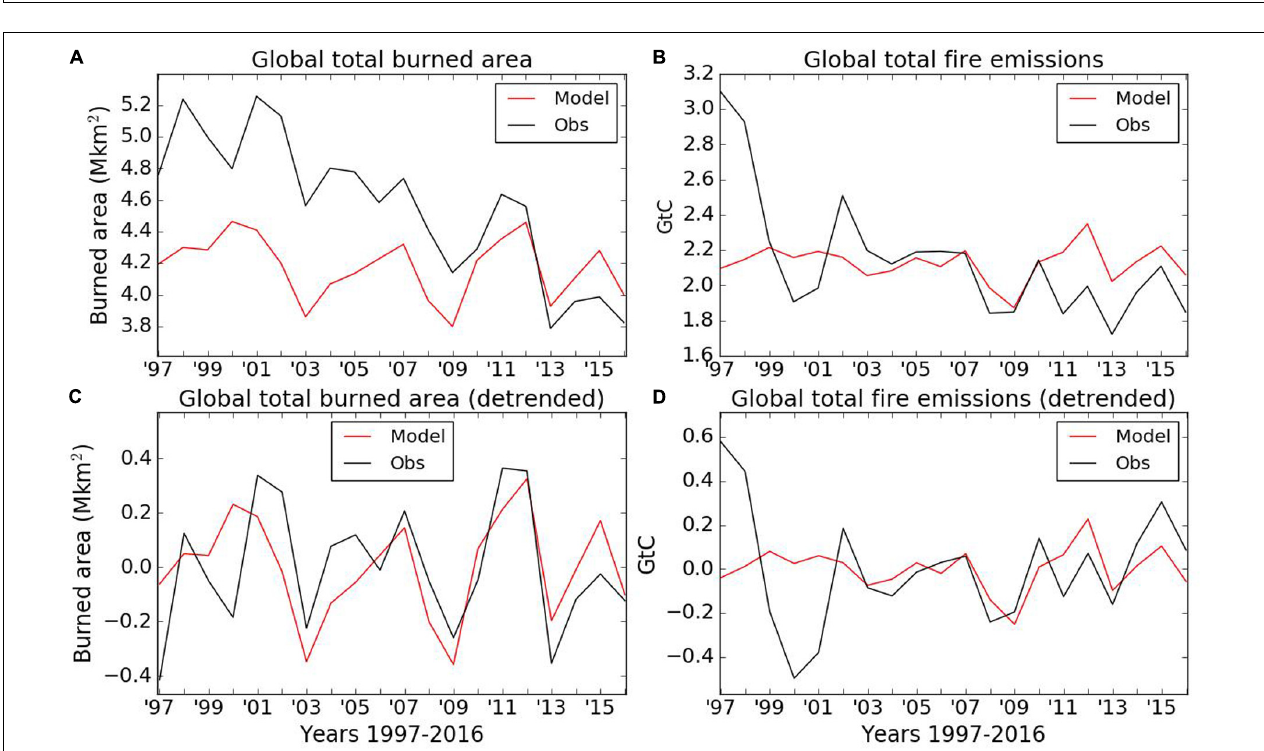
FIGURE 1 | Gridbox total burned area from GFED observations (A) and as modeled by JULES-INFERNO (B) , July 2015–June 2016.